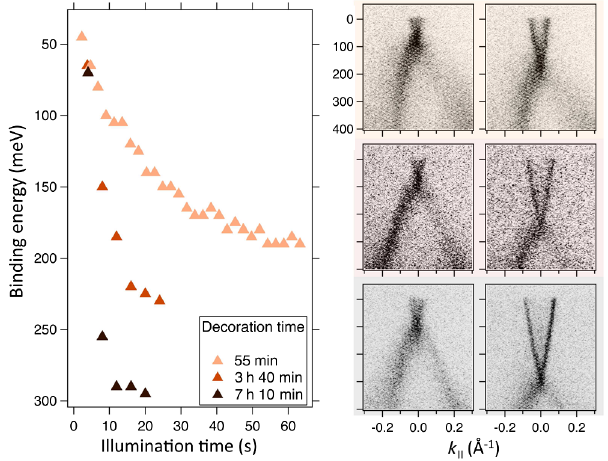
FIG. 3. The effect of surface decoration on the evolution of surface band bending during a typical ARPES experiment on 3D TIs. Left-hand column: Binding energy of the Dirac point in Bi 1 Sb 0 Te 1 Se 1 as a function of illumination time after the . 46 . 54 . 7 . 3 surface has been exposed for differing times to UHV residual gas molecules, as given in the legend. Center (right-hand) panels: I ð E; k Þ images showing the surface band structure of Bi 1 Sb 0 Te 1 Se 1 which underlie the data points in the . 46 . 54 . 7 . 3 left-hand graphic for EUV exposure times of 1 s (20 s). The pressure before and during measurements was 1 . 0 × 10 − 10 and 5 . 0 × 10 − 11 mbar, respectively. All data have been acquired at 16 K using a photon flux of 3 . 2 × 10 21 photons = ð s m 2 Þ , with a photon energy of 27